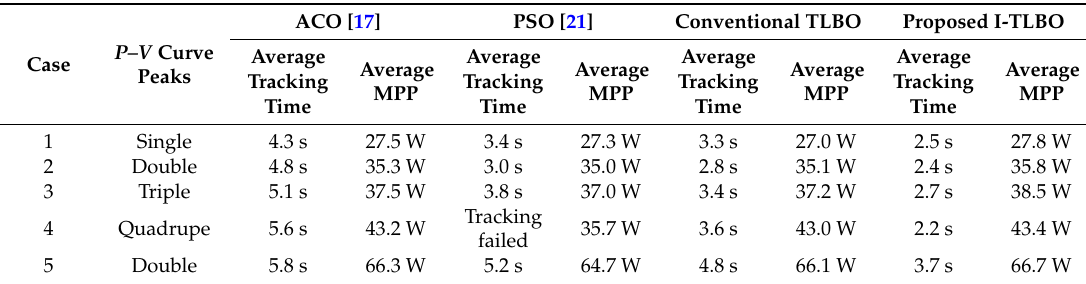
Table 6. Comparison between the measurement results of the five cases obtained using ACO, PSO, conventional TLBO and the proposed I-TLBO.